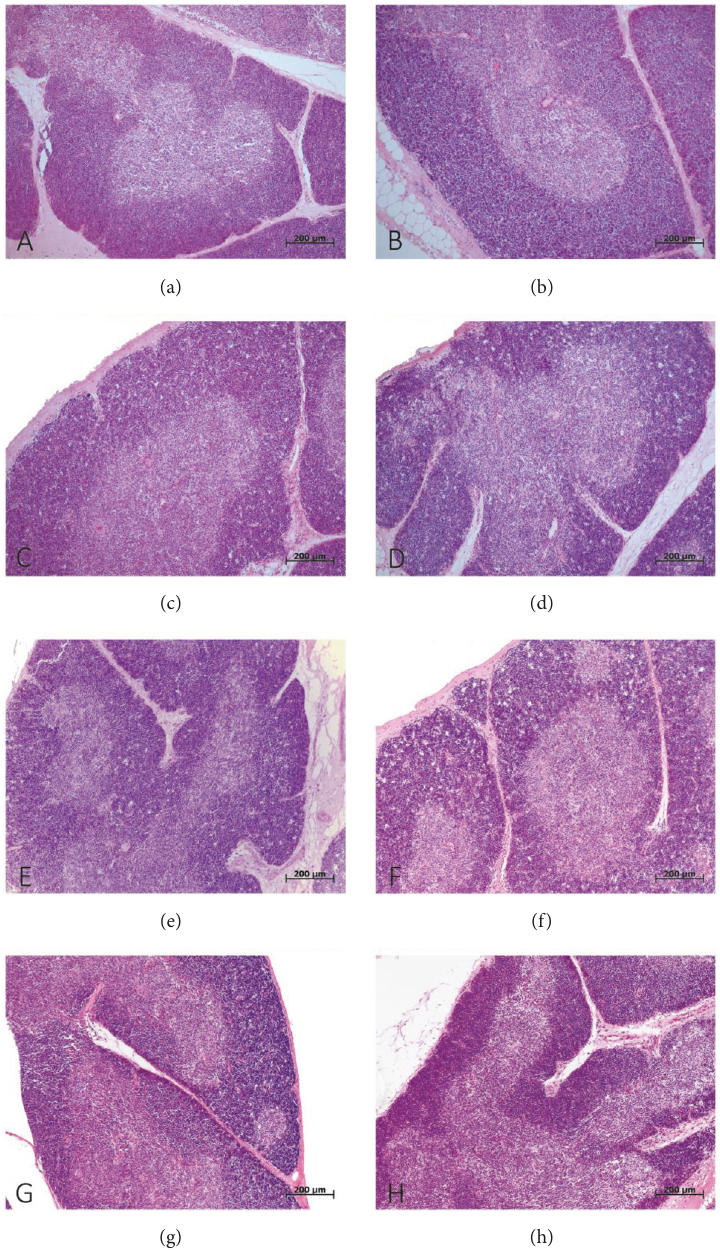
Figure 3: Morphological changes in the thymus of tolerant- and susceptible-to-hypoxia male Wistar rats after 3, 6, and 24 hours of LPS administration. Hematoxylin and eosin staining. Original magnification: 100x. (a) Tolerant-to-hypoxia rat, control group; cortex is wide, and the border between the cortex and medulla is readable. (b) Susceptible-to-hypoxia rat, control group; the proportion of the cortex/medulla is 1:1, and the border between them is readable. (c) Tolerant-to-hypoxia rats, 3 h LPS; narrowing of cortex (with a starry-sky aspect). (d) Susceptible-to-hypoxia rats, 3 h LPS; mild involution, narrowing of cortex, more pronounced compared with tolerant ones. (e) Tolerant- to-hypoxia rats, 6 h LPS; mild involution; the cortex is narrow. (f) Susceptible-to-hypoxia rats, 6 h LPS; a pronounced starry-sky aspect, devastation of cortex, and macrophages and dying lymphocytes. (g) Tolerant-to-hypoxia rats, 24 h LPS; narrow cortex; the border between the cortex and medulla is readable. (h) Susceptible-to-hypoxia rats, 24 h LPS; narrow cortex; the border between the cortex and medulla is